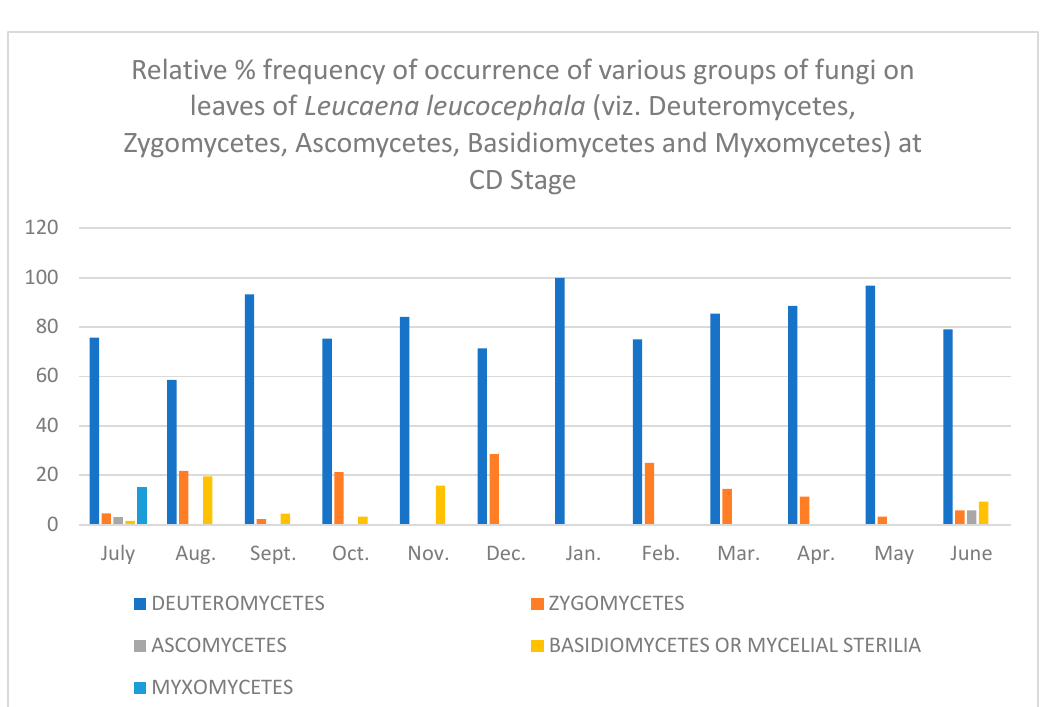
Figure 6. Relative % frequency of occurrence of various groups of fungi on leaves of Leucaena leucocephala (viz. Deuteromycetes, Zygomycetes, Ascomycetes, Basidiomycetes and Myxomycetes) at CD Stage.